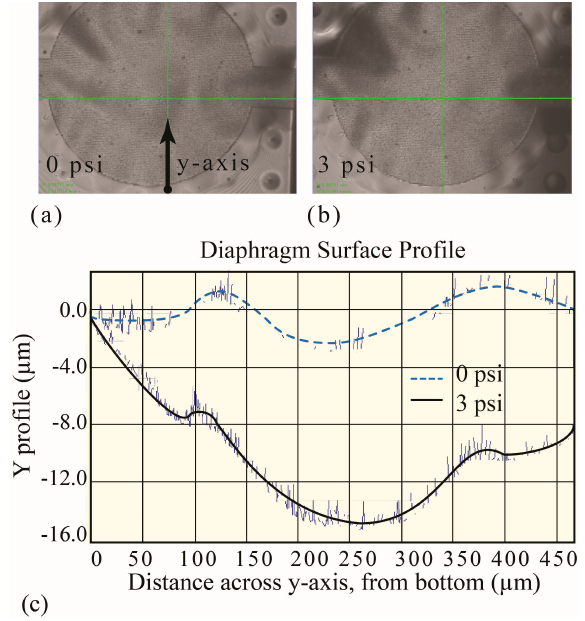
Figure A3. Membrane deflection images and graph. ( a , b ) From the Wyko interferometer of the pump diaphragm at rest, 0 psi, and at 3 psi; ( c ) Data from the Wyko showing the maximum deflection at the center of a 500-µm diameter diaphragm.